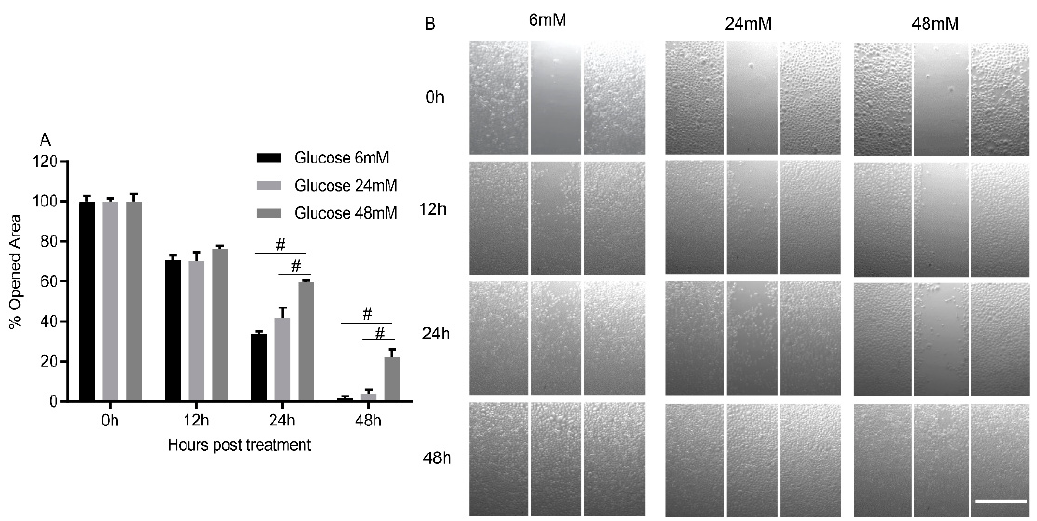
Figure 2. High glucose inhibits the migration of oral keratinocytes. TIGK cells were seeded in a 3- well silicone insert. When cells reached 100% confluence, cells were treated with 1 µ g/mL mitomycin C to stop cell proliferation. After the inserts were removed, culture media was switched to ones with higher concentrations of glucose (24 mM and 48 mM). Images were taken at 0, 12, 24, and 48 h. Gap area in pixels was assessed by ImageJ software. There were 6 replicates in the low glucose group (6 mM) and 3 replicates in each high glucose group for each time point. Percent of opened areas was calculated based on the initial gap area. ( A ). Summary of TIGK cell migration under high glucose conditions. # p < 0.01. One-way ANOVA followed by Tukey’s post-test was used for statistical analysis. ( B ). Representative images of TIGK cell migration. Scale bar: 500 μ M.